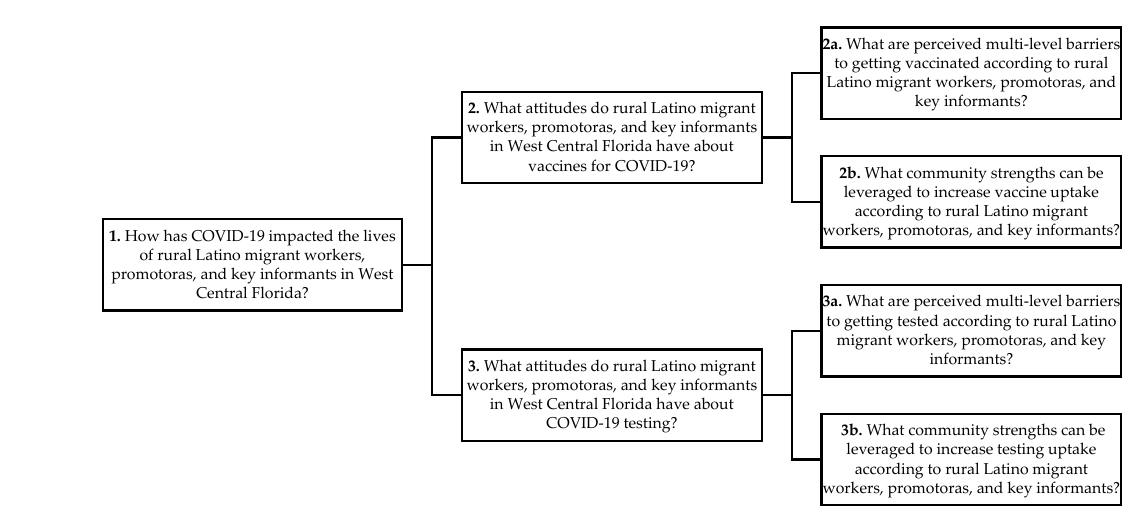
Figure 1. Research questions to examine the barriers that affect COVID-19 testing and vaccine uptake at the individual, interpersonal, institutional (e.g., healthcare system), and community levels in southwest Florida rural Latino migrant and immigrant communities.